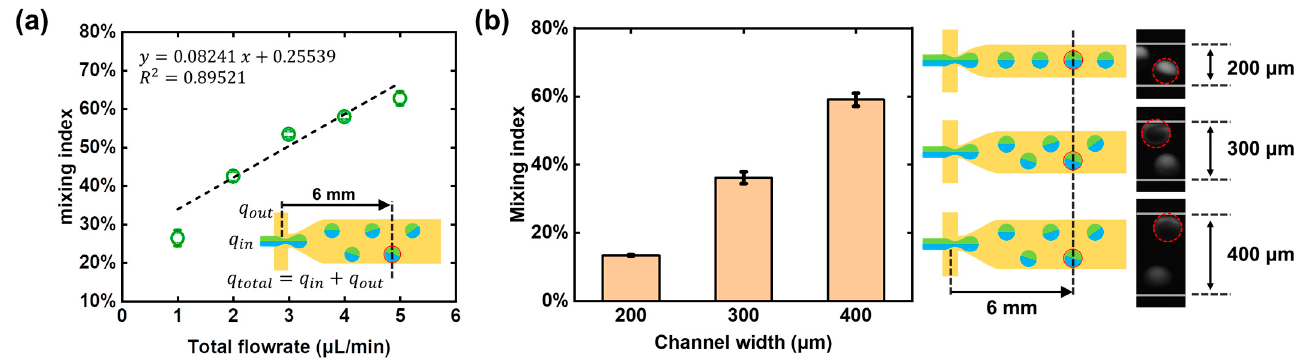
Figure 6. Other factors affecting the mixing index including “total flow rate” and “channel width”. ( a ) Flow rate dependence of mixing index. Each standard deviation under different flow rates was obtained from three independent experiments in the same microfluidic chip. ( b ) The effect of channel width on mixing index. Each standard deviation under different channel width was obtained from three independent experiments at the same flow conditions. The real-time pictures right-side had shown the different mixing states in these three kinds of microchannels.